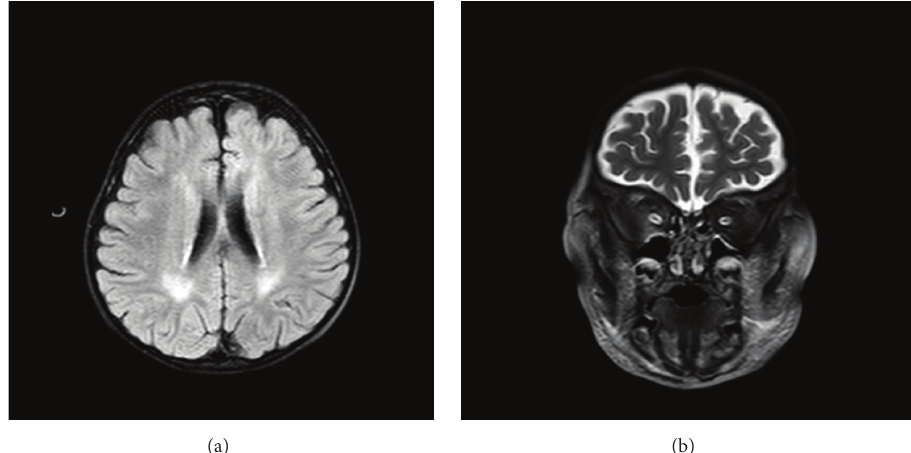
Figure 1: Brain magnetic resonance images: (a) The axial FLAIR image shows periventricular white matter signal changes compatible with hypomyelination. (b) Coronal T2-weighted magnetic resonance image shows bilateral optic atrophy and cerebral